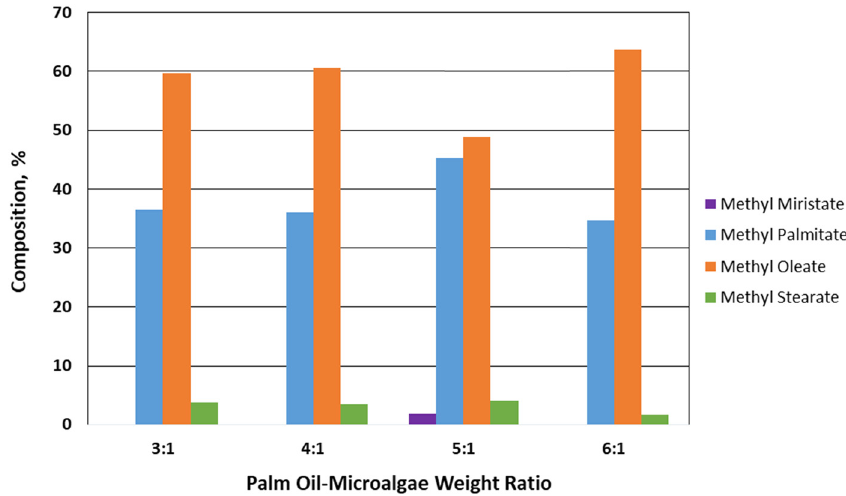
Figure 5: Major FAME composition for various palm oil – microalgae weight ratios.